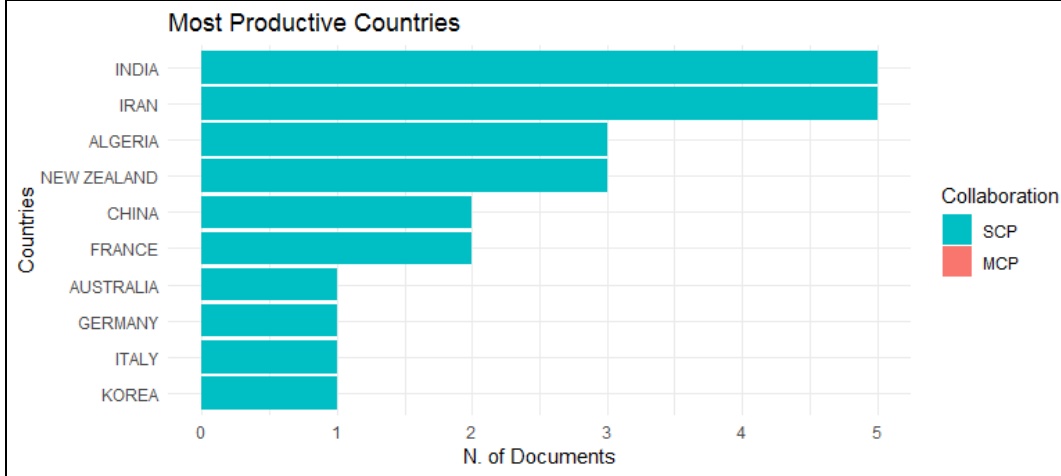
Figure 5. Most productive countries.